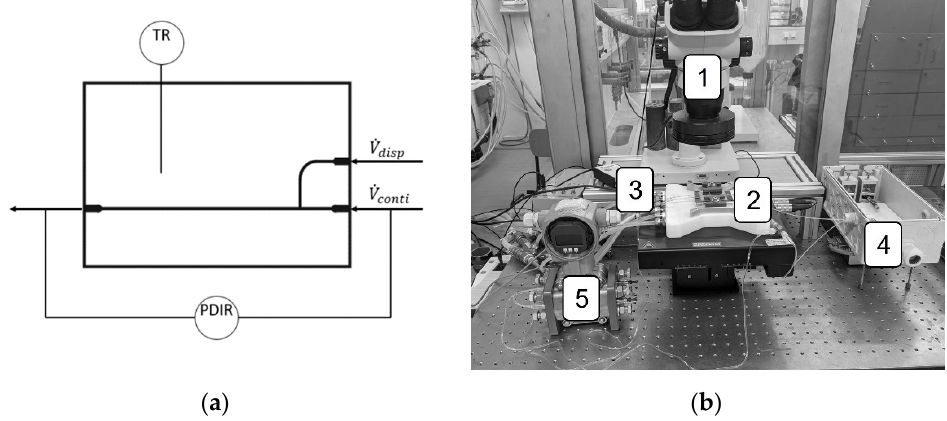
Figure 1. ( a ) Schematic drawing of the connection of the pressure sensor to the microfluidic chip. V disp and V conti show where the dispersed and continuous phases were connected to the microfluidic chip. The channel where the dispersed phase ( V disp ) entered the system could be closed to increase the accuracy of the measurements of ∆ p . The dispersed phase is forming droplets at the T-junction, where the two streams meet. ( b ) Experimental setup: (1) stereo microscope with polarization filter and high-speed camera, (2) microfluidic chip on top of the tempering unit, (3) in- and outlet of coolant, (4) syringe pump, and (5) differential pressure sensor.